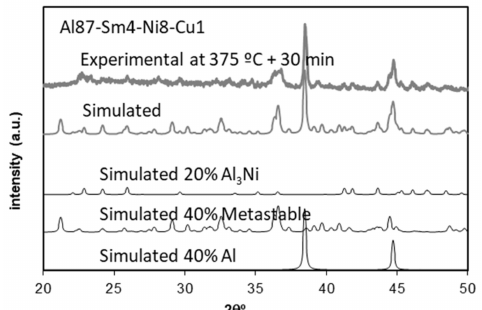
Figure 9. XRD patterns of the Al 87 -Sm 4 -Ni 8 -Cu 1 ribbon treated to 375 ◦ C + 30 min. The simulated pattern considered proportions of 40 / 40 / 20 for Al, Al 3 Ni, and the metastable phase.